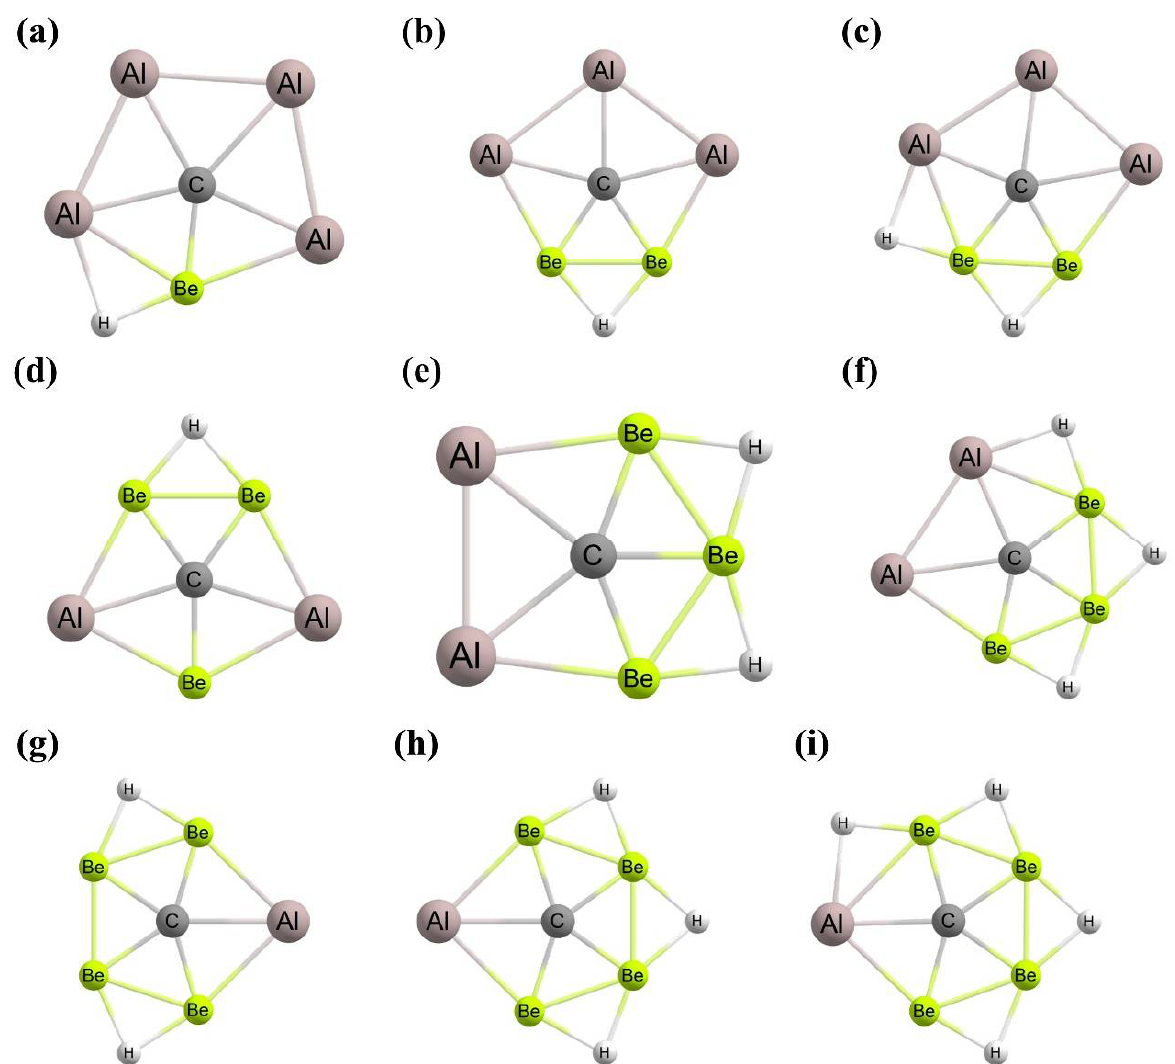
Figure 24. Optimized structures of ( a ) CAl 4 BeH 4+ , ( b ) CAl 3 Be 2 H, ( c ) CAl 3 Be 2 H 2+ , ( d ) CAl 2 Be 3 H − , ( e ) CAl 2 Be 3 H 2 , ( f ) CAl 2 Be 3 H 3+ , ( g ) CAlBe 4 H 2− , ( h ) CAlBe 4 H 3 , and ( i ) CAlBe 4 H 4+ clusters.